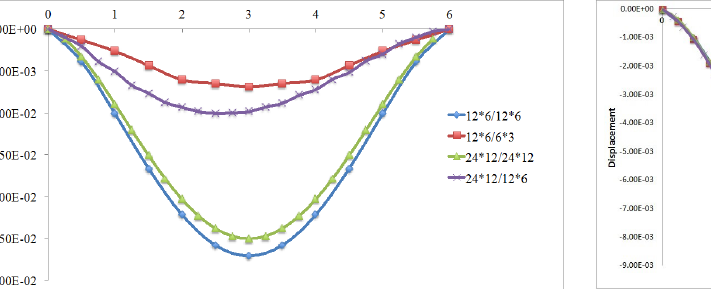
Figure 18: Transverse displacement u 3 distribution with Q8 ele- ments using conforming and non-conforming mesh